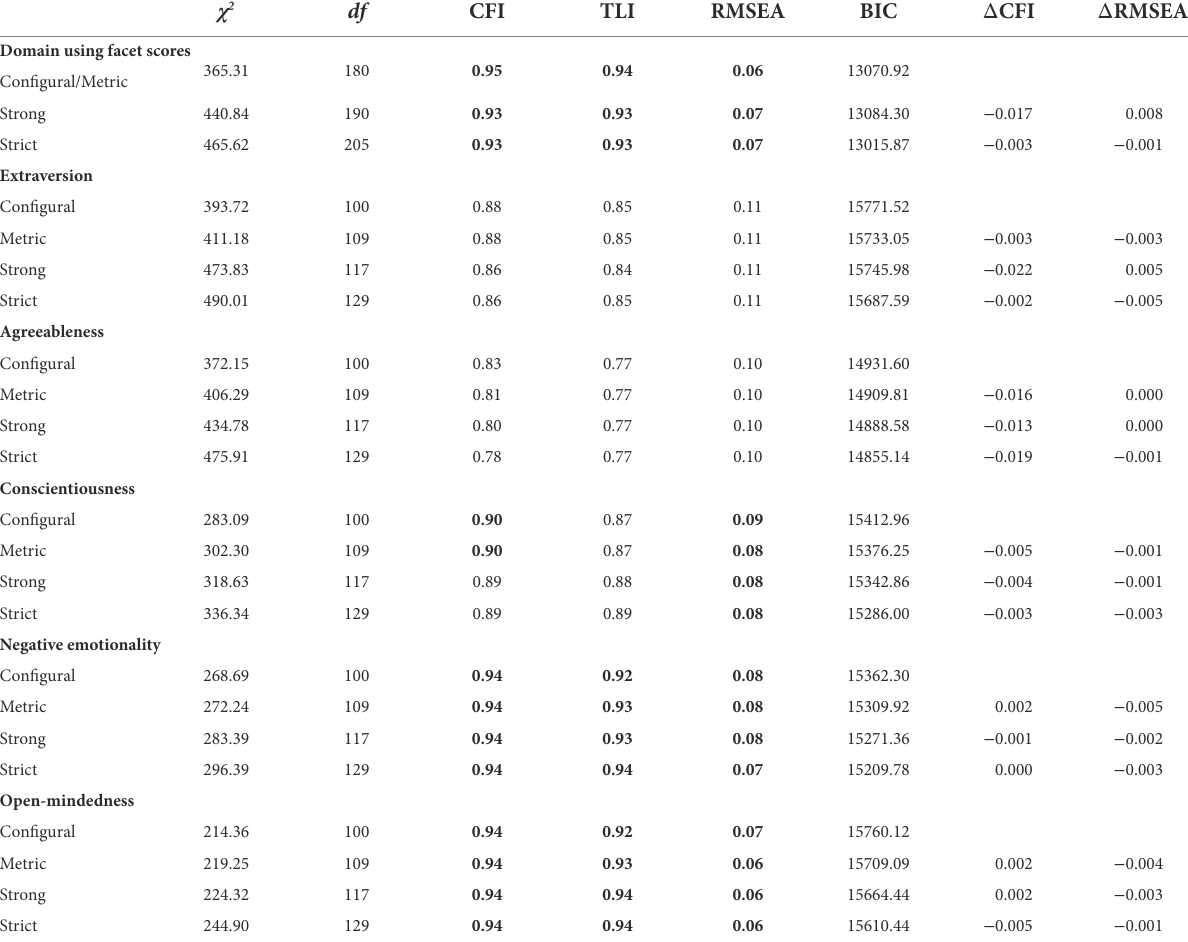
TABLE 8 Fit statistics for measurement invariance analyses at each sex